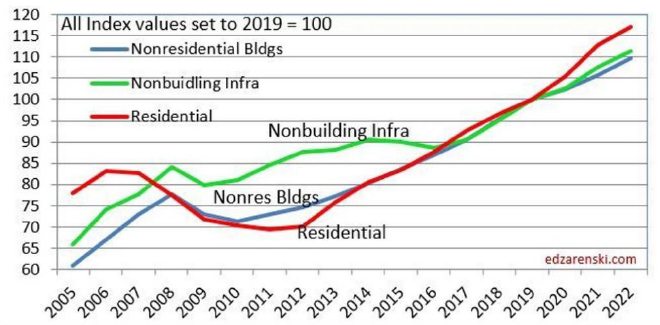
Fig. 2 Historical trends of the three market composite